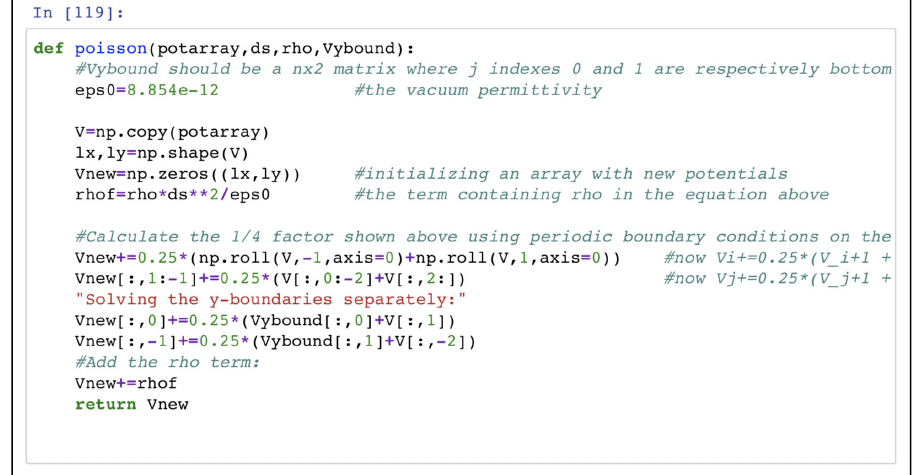
FIG. 4. Example of array-based calculations, implemented to solve Poisson ’ s equation through the method of